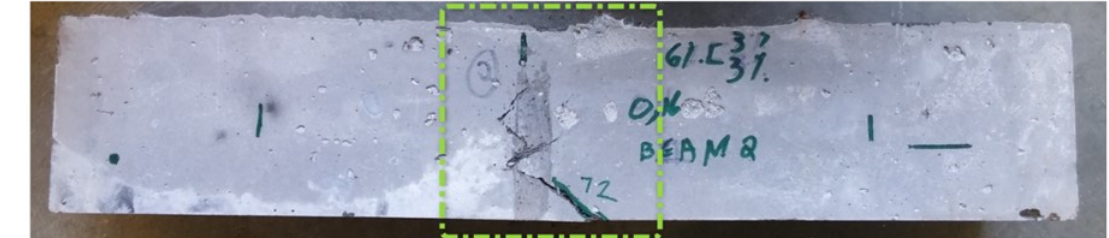
Figure 18. Contour diagrams of the displacement (along axis Y) of the specimen.